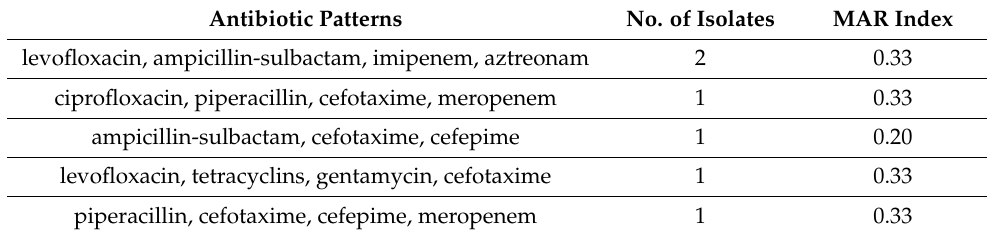
Table 3. Antimicrobial resistance patterns of A. baumannii isolates.